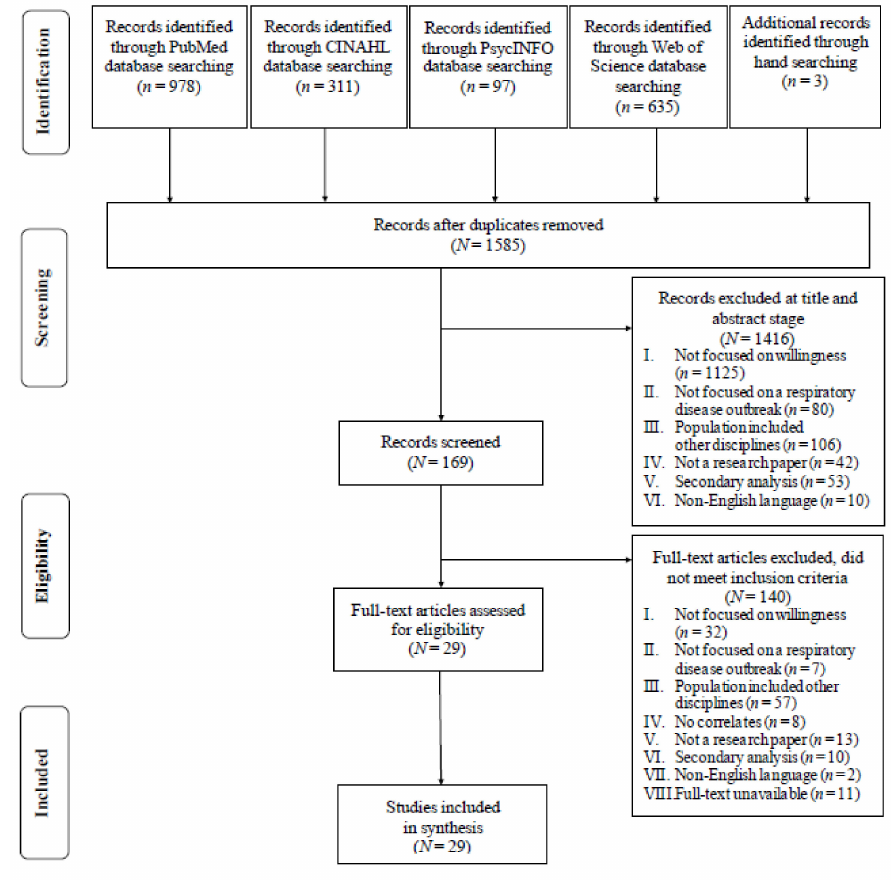
Figure 1. Preferred Reporting Items for Systematic Reviews and Meta-Analyses Flowchart of Article Selection for